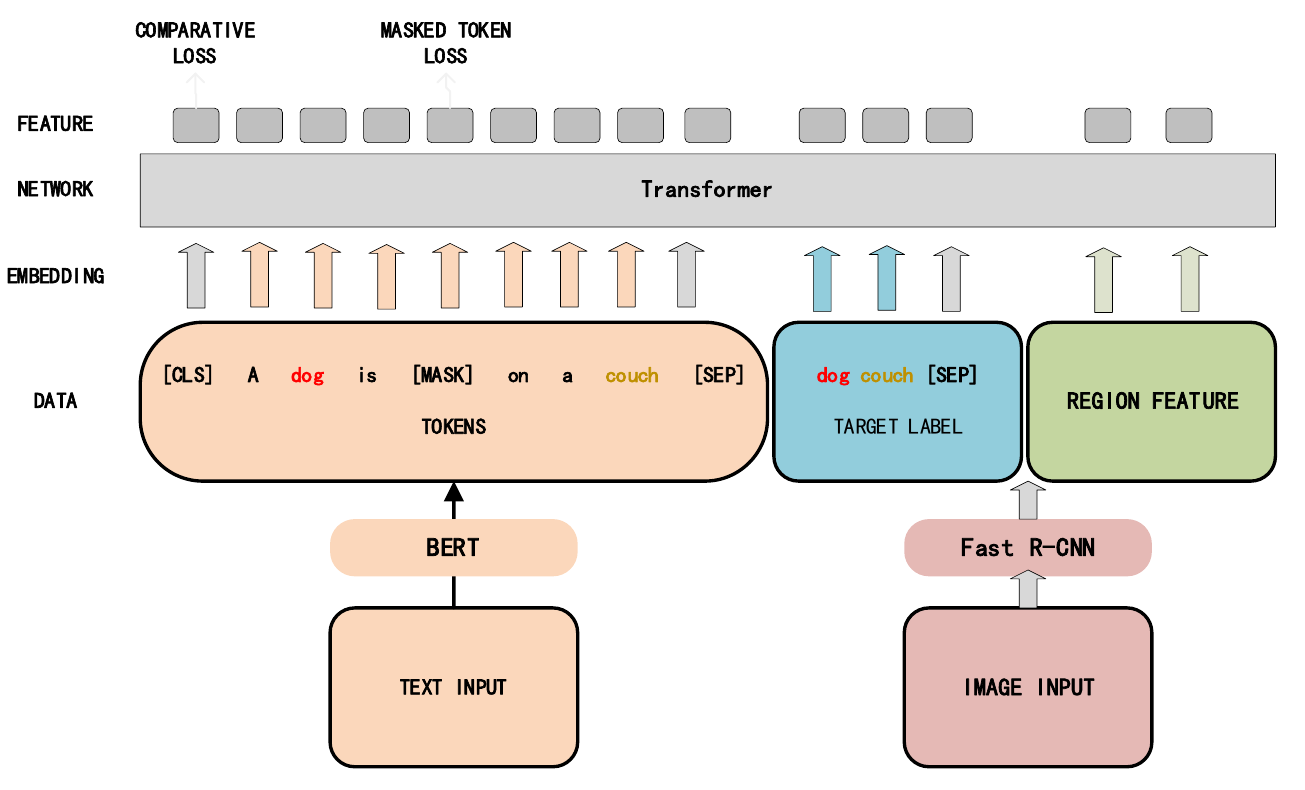
Figure 4. Schematic diagram of Oscar.